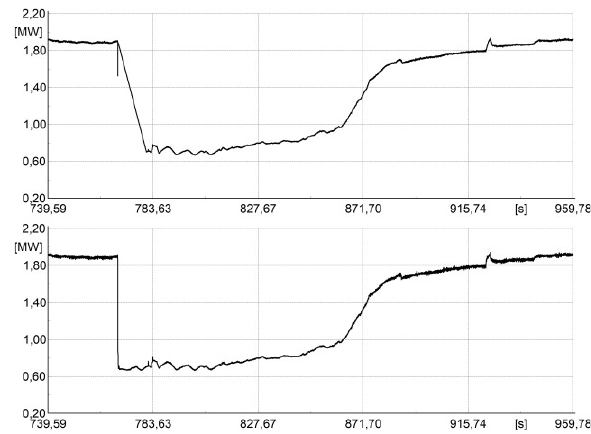
Figure 11. Calculation: transient process of the drilling installation operation with ESS in the regime of limiting the rate of change in power (from top to bottom - the power of the generator, the load